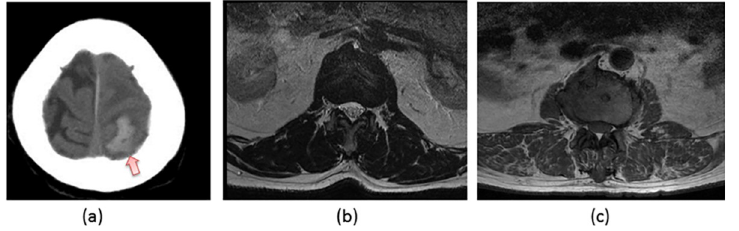
Fig 4. Example of incorrect prediction by our proposed CNN architecture is shown. (a) CT of brain image misclassified as MRI of brain image in the validation set. (b) MRI of spine image misclassified to CT of brain in the validation set. (c) MRI of spine image misclassified to MRI of brain in testing set. Notice the image in (a) contains intracerebral hemorrhage